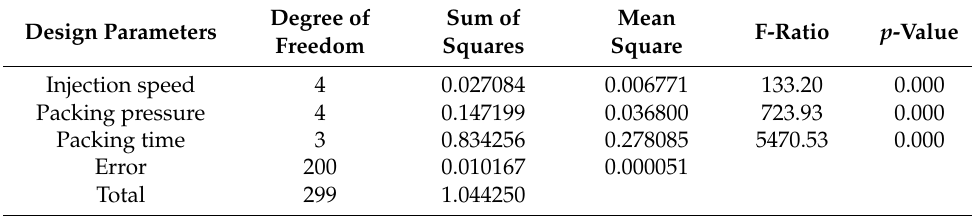
Figure 13. Effect of process parameters on the part weight. Table 4. Analysis of variance (ANOVA) of process parameters for part weight.